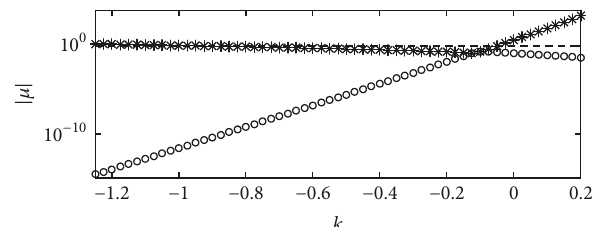
Figure 15: Magnitude of the Floquet multipliers for different values of 𝑘 for the TUPO2 controlled by the aPBC.